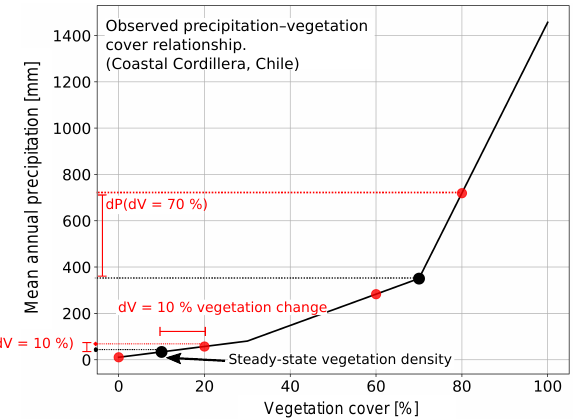
Figure 5. Graphical representation of the observed precipitation – vegetation relationship in the Chilean focus areas (shown in Fig. 1), and how precipitation amounts were selected when perturbations in vegetation cover were imposed. Black dots represent vegetation– precipitation values used in the steady-state model conditions and prior to any transients. Red dots show how vegetation cover pertur- bations of ± 10% in the model simulations were used to select cor- responding mean annual precipitation amounts. Note that the ob- served relationship between observed precipitation and vegetation cover in the Chilean Coastal Cordillera is nonlinear, and is a source of the nonlinear behavior in the model forcing (e.g., Fig. 4) and re- sults (Fig. 17) presented